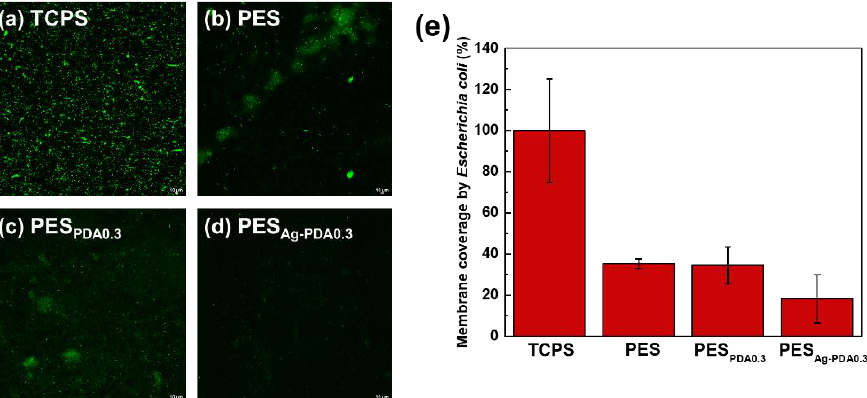
Figure 10. Antibacterial capability of the membranes assessed via the attachment of E. coli. ( a – d ) Representative confocal micrographs of the membranes, and ( e ) quantified bacterial coverage via ImageJ software.